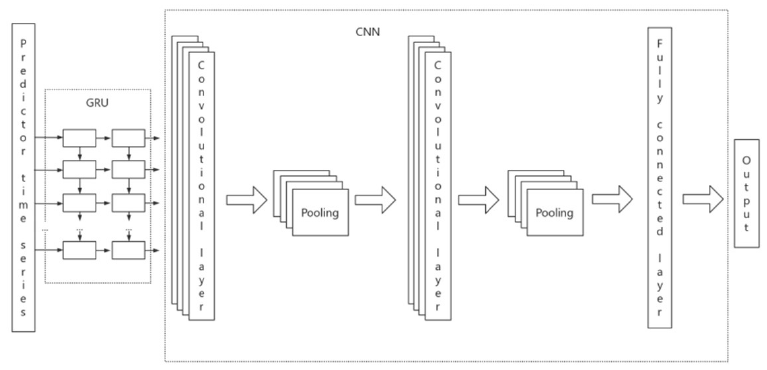
Figure 5. Structure diagram of GRU–CNN model.